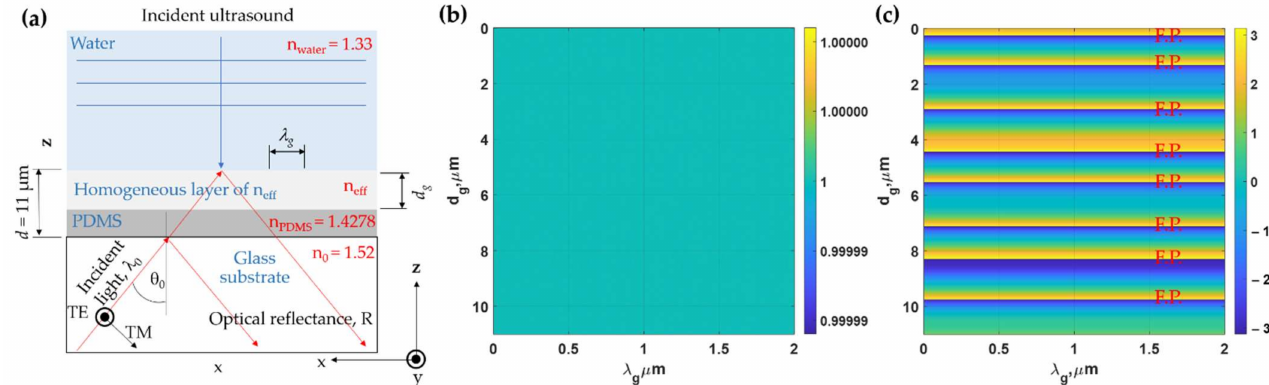
Figure 8. ( a ) Simplified model with homogenous layer and n eff , ( b ) reflectance of the simplified model, and ( c ) phase of reflection coefficients calculated using RCWA for the simplified model in Figure 8a when illuminated by TM polarized light at 685 nm and the n 0 sin θ 0 of 1.37.